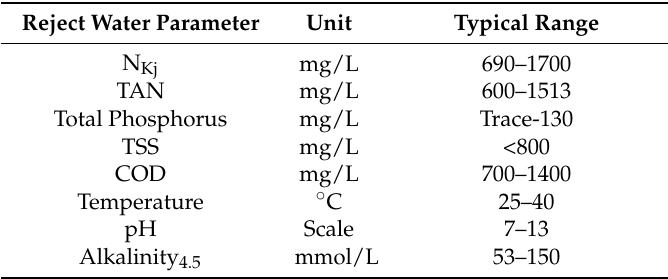
Table 5. Typical composition of reject